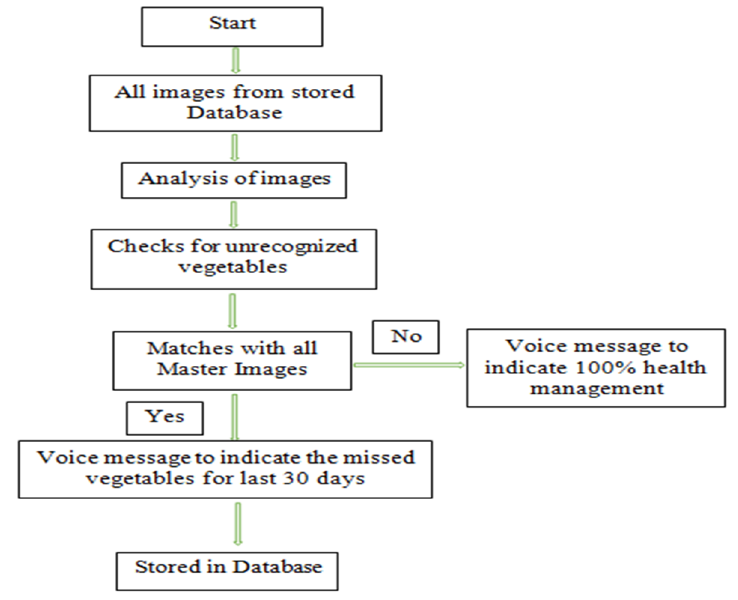
Figure 1. Intelligent refrigerator using artificial intelligence [87].